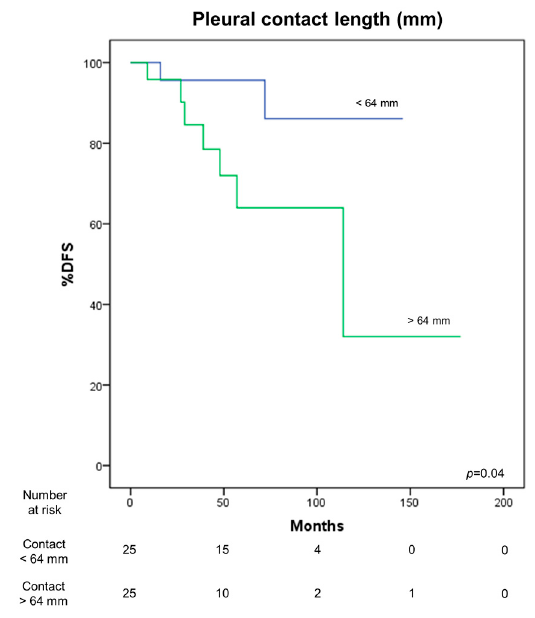
Figure 7. Correlation between DFS and pleural contact length.